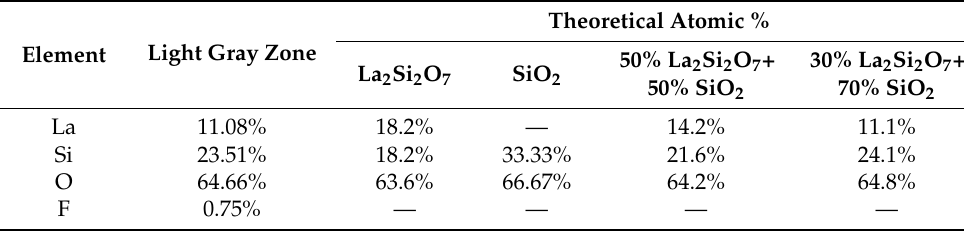
Table 7. EDX results of the light gray zone and the theoretical atomic percentages of different elements of the possible products in Si-La